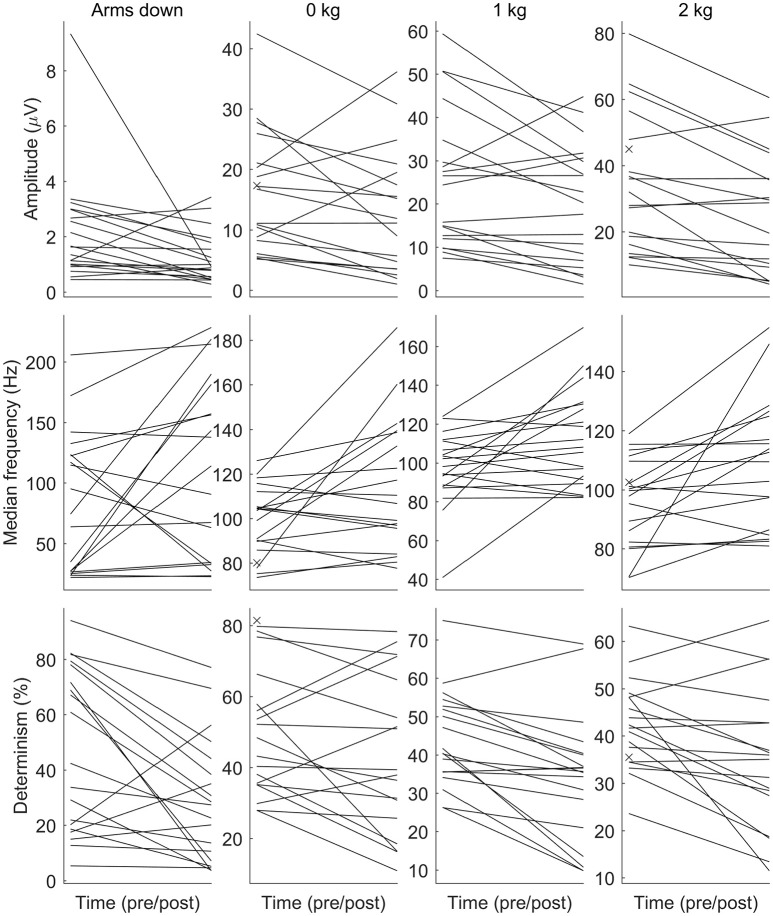
The amplitude (RMS), the median frequency, and the determinism of surface electromyogram before and after the dry immersion. The amplitude and the determinism tend to decrease, while the median frequency tends to increase after the dry immersion. Each patient is denoted by a line. Each subplot corresponds to a combination of a parameter (the row) and a loading (the column). Loading conditions are the following: arms down without any load (Arms down); 0/1/2 kg loading on each hand with elbow being flexed to 90°. The muscle is the biceps of the left arm. The pre-immersion values are marked with crosses when the post-immersion counterpart is missing.